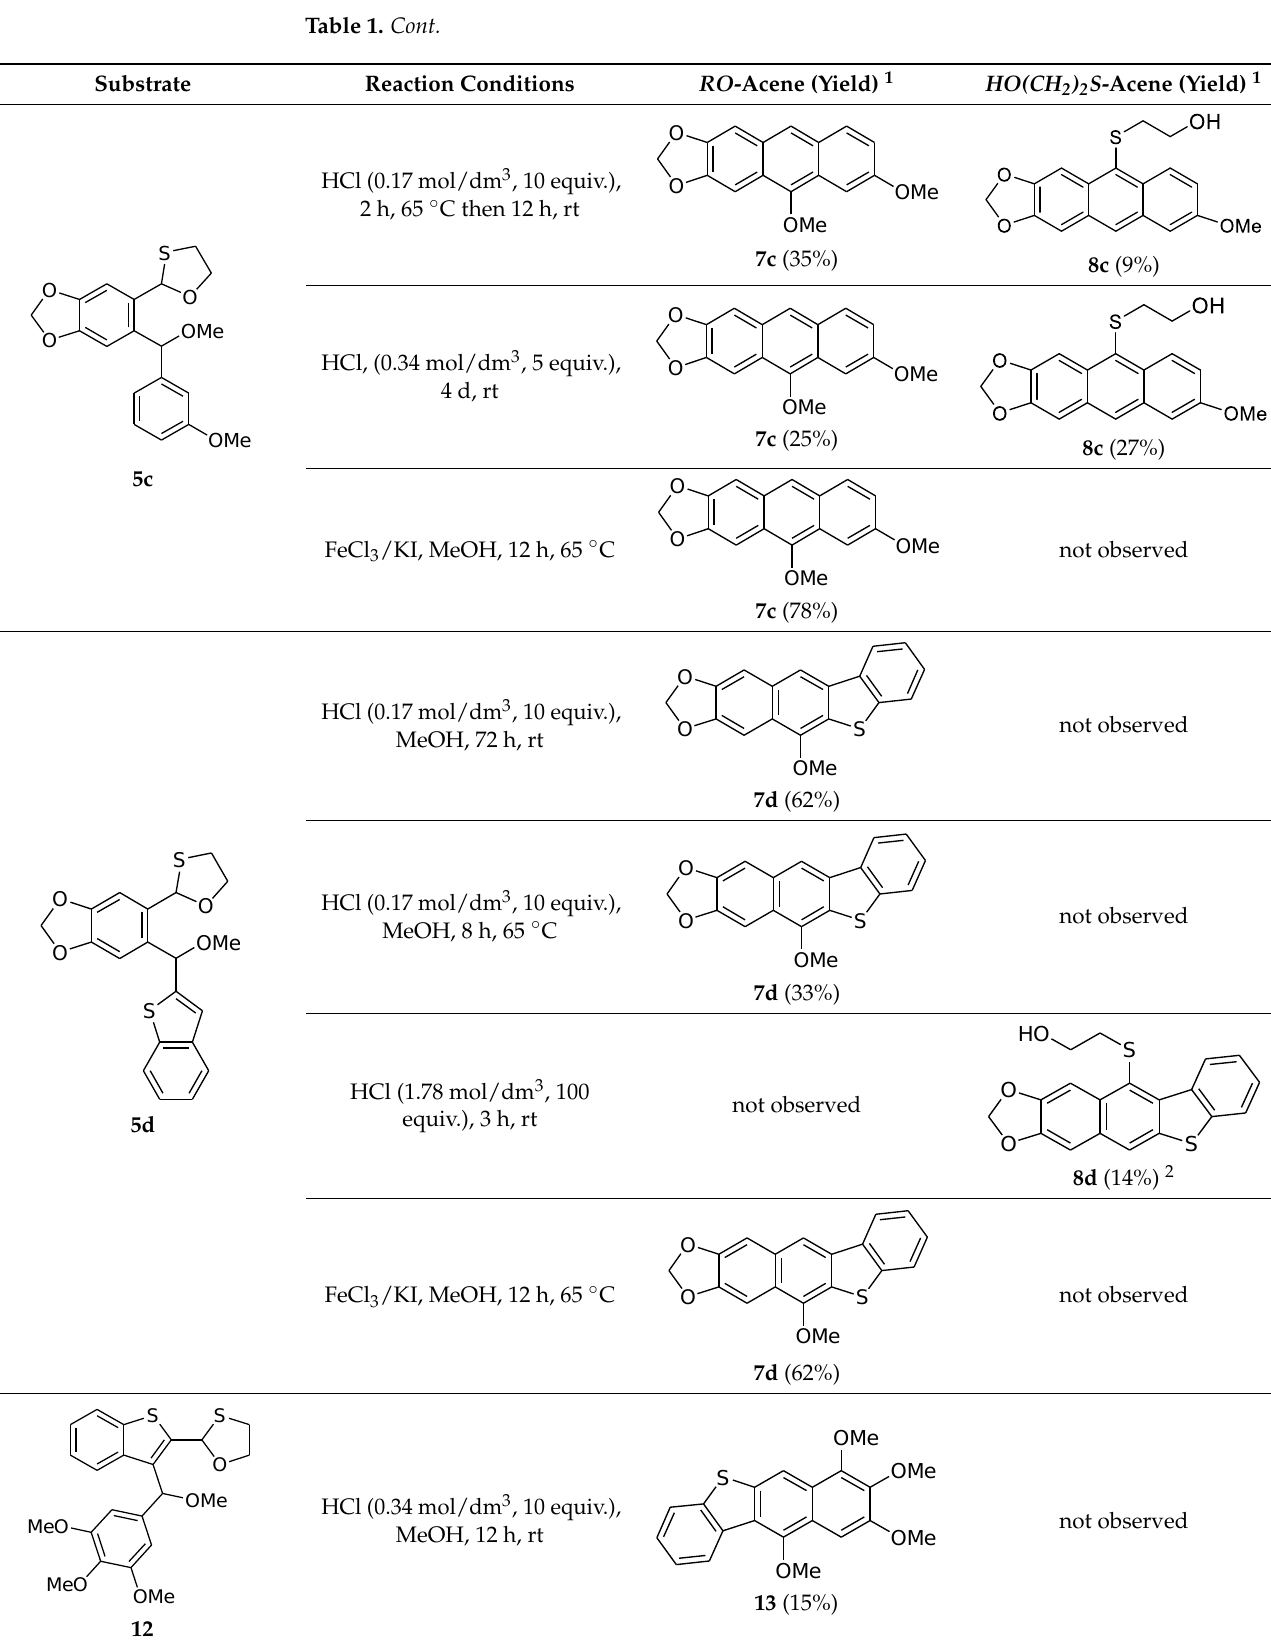
1 isolated yields; 2 yield based on 1 H NMR spectrum (not